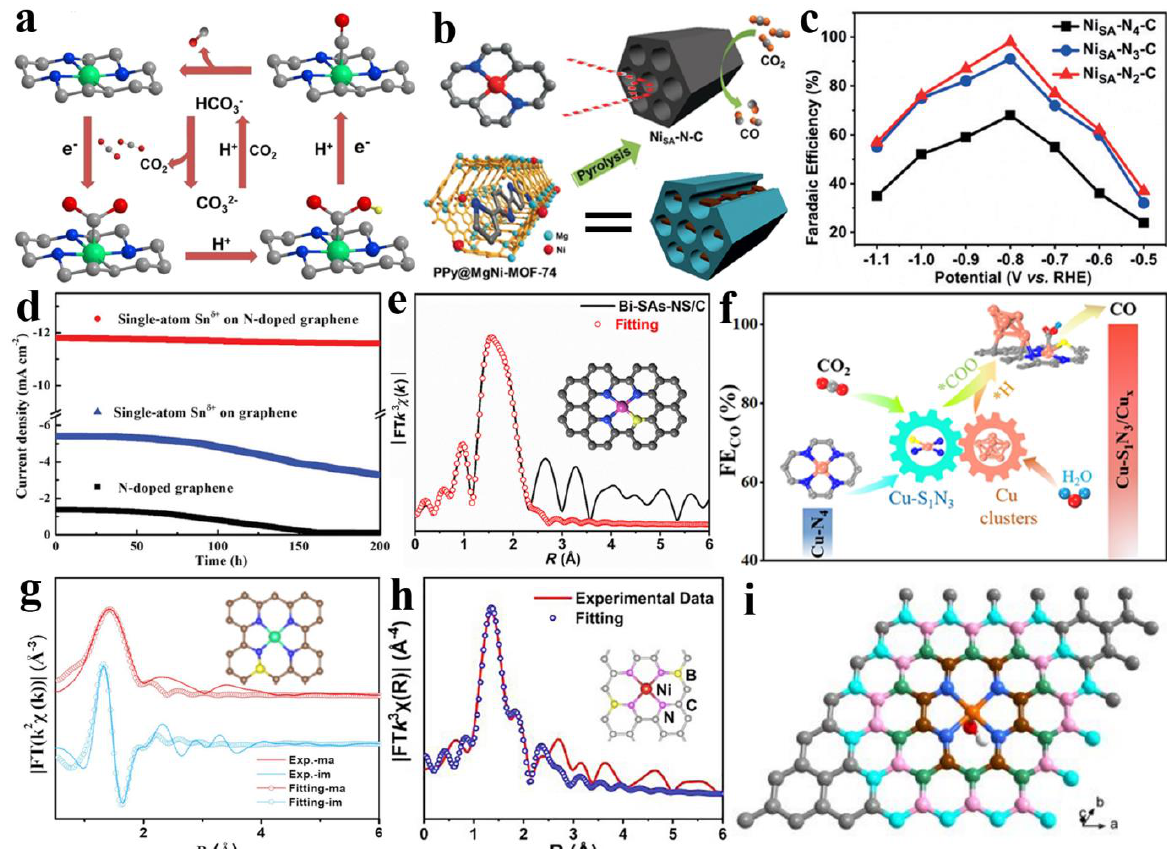
Figure 5. ( a ) Proposed reaction paths of Ni SAs/N-C for CO 2 RR. Reprinted with permission